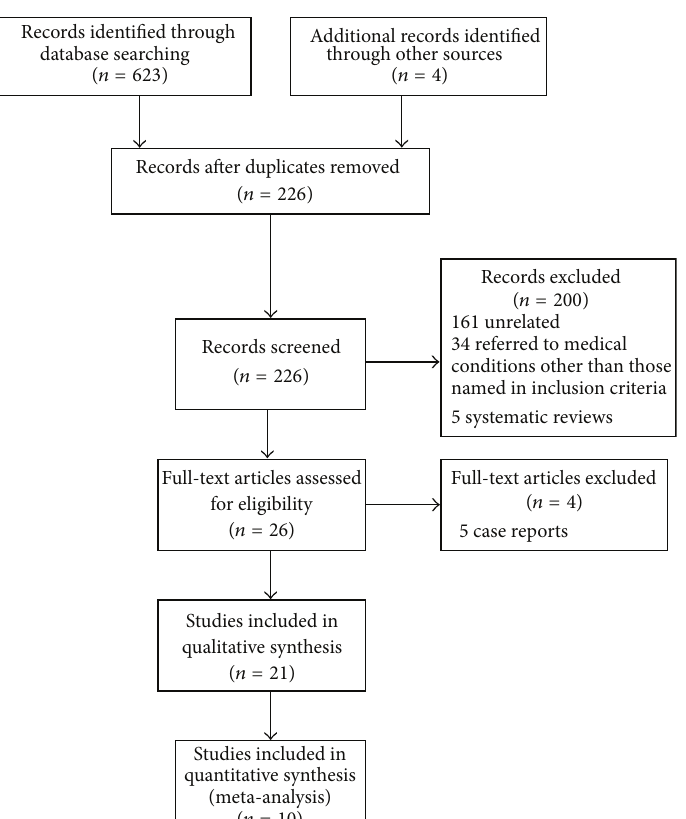
Figure 1: Systematic review and meta-analysis flow